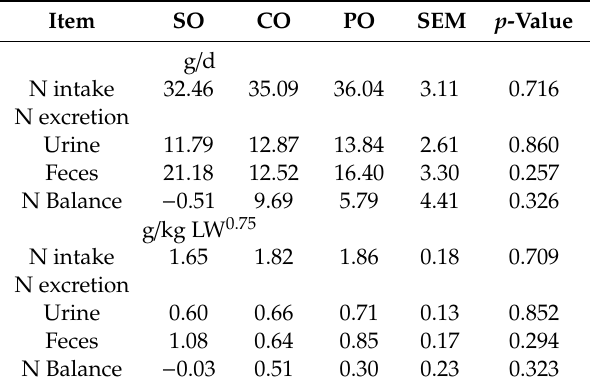
Table 4. Nitrogen balance (g / d, g / kg LW 0.75 ) in dairy goats fed with sa ffl ower oil (SO), canola oil (CO) and palm oil (PO) treatments 1